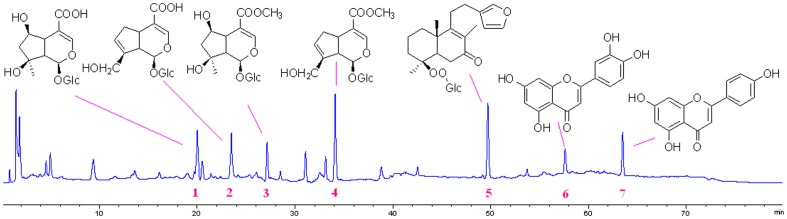
Chromatograms of MEAP and structures of the seven major components of MEAP.1–7: shanzhiside, geniposidic acid, shanzhisidemethyl ester, geniposide, phlomisoside F, luteolin and apigenin.